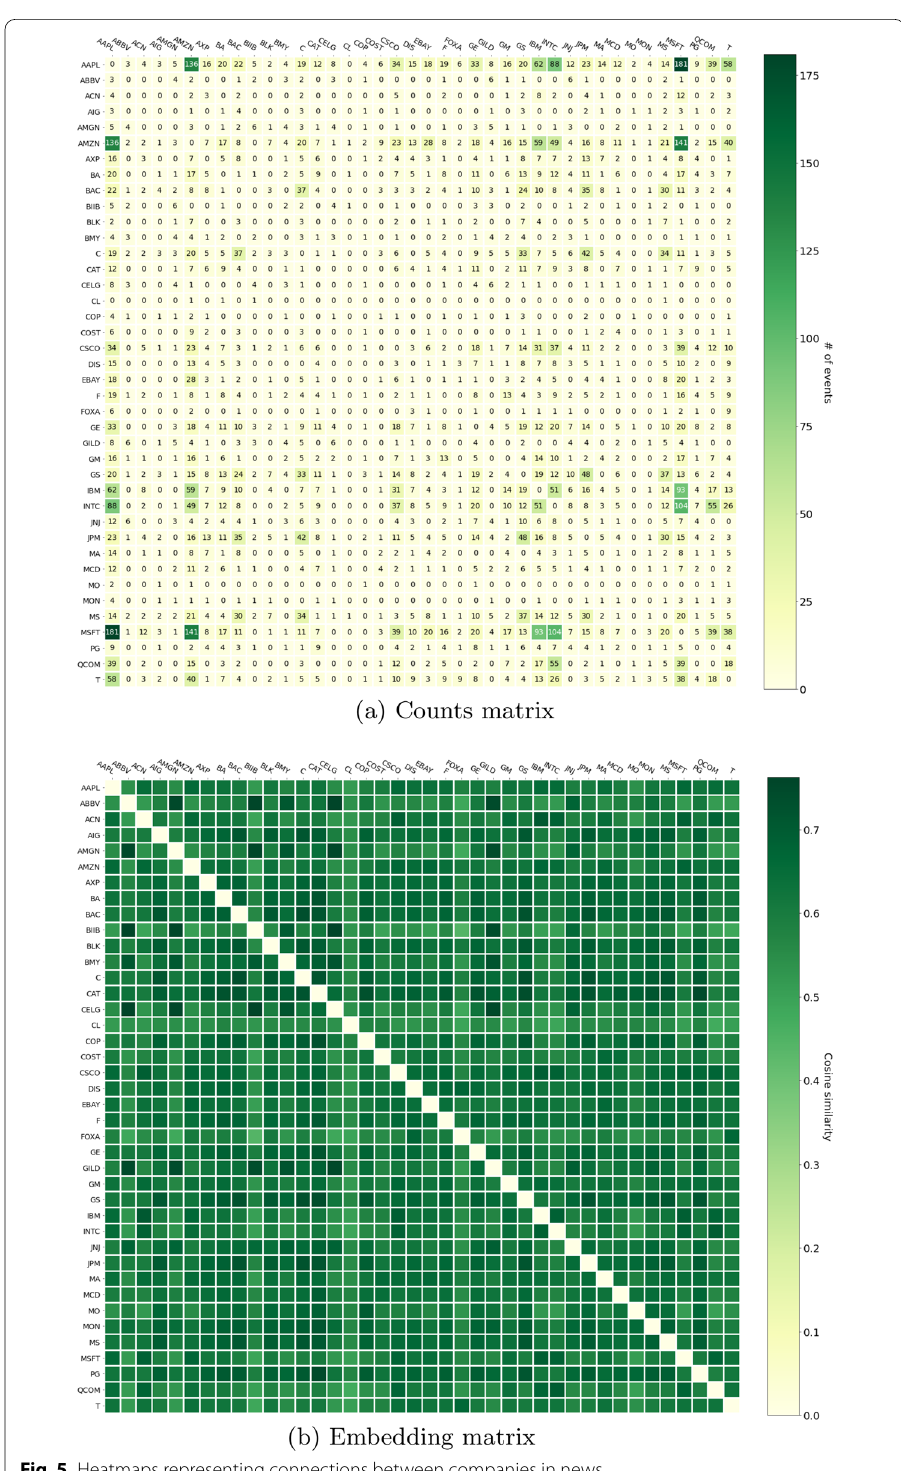
Fig. 5 Heatmaps representing connections between companies in